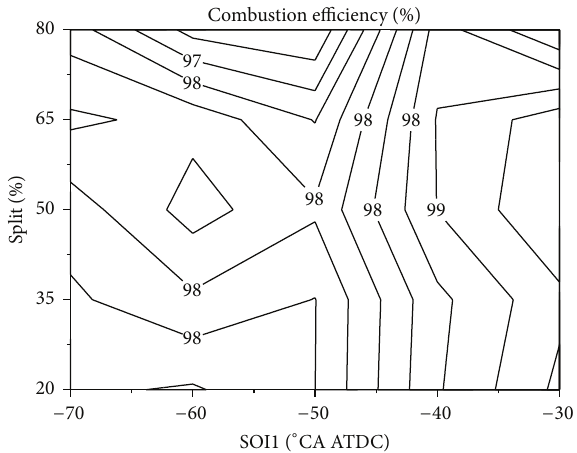
Figure 7: Combustion efficiency as a function of SOI1 and split percentage.